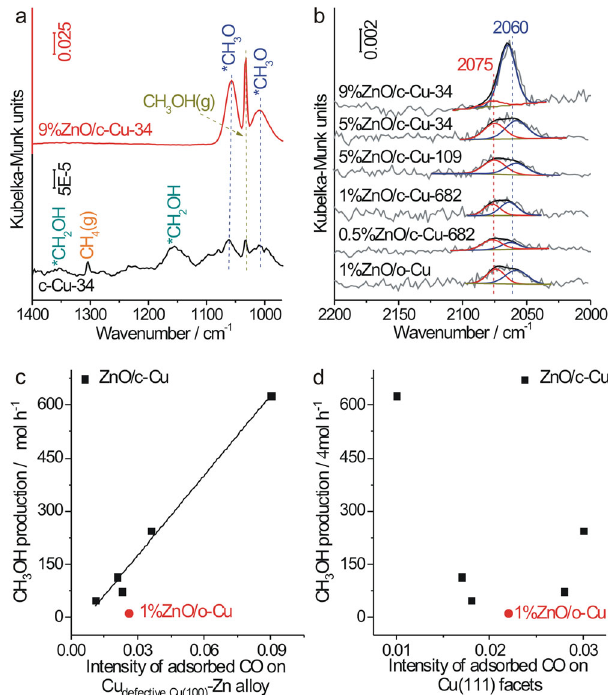
Fig. 7 Reaction mechanism of CO hydrogenation reaction. a In situ DRIFTS spectra of c-Cu-34 and 9%ZnO/c-Cu-34 catalysts under 33.3% CO + 66.7% H 2 (total pressure: 2MPa) at 523K. b In situ transmission FT-IR spectra of CO adsorption (P CO = 1000Pa) at 123K on various used ZnO/Cu catalysts in CO hydrogenation to methanol reaction without exposure to air, and the red and blue lines represent the fi tted vibrational peaks of CO adsorbed on the Cu{111} facets and CuZn alloy, respectively. CH 3 OH productions over various ZnO/Cu catalysts as a function of the intensity of CO adsorbed on c Cu defective Cu(100) -Zn alloy and d Cu{111} facets derived from corresponding DRIFTS results.